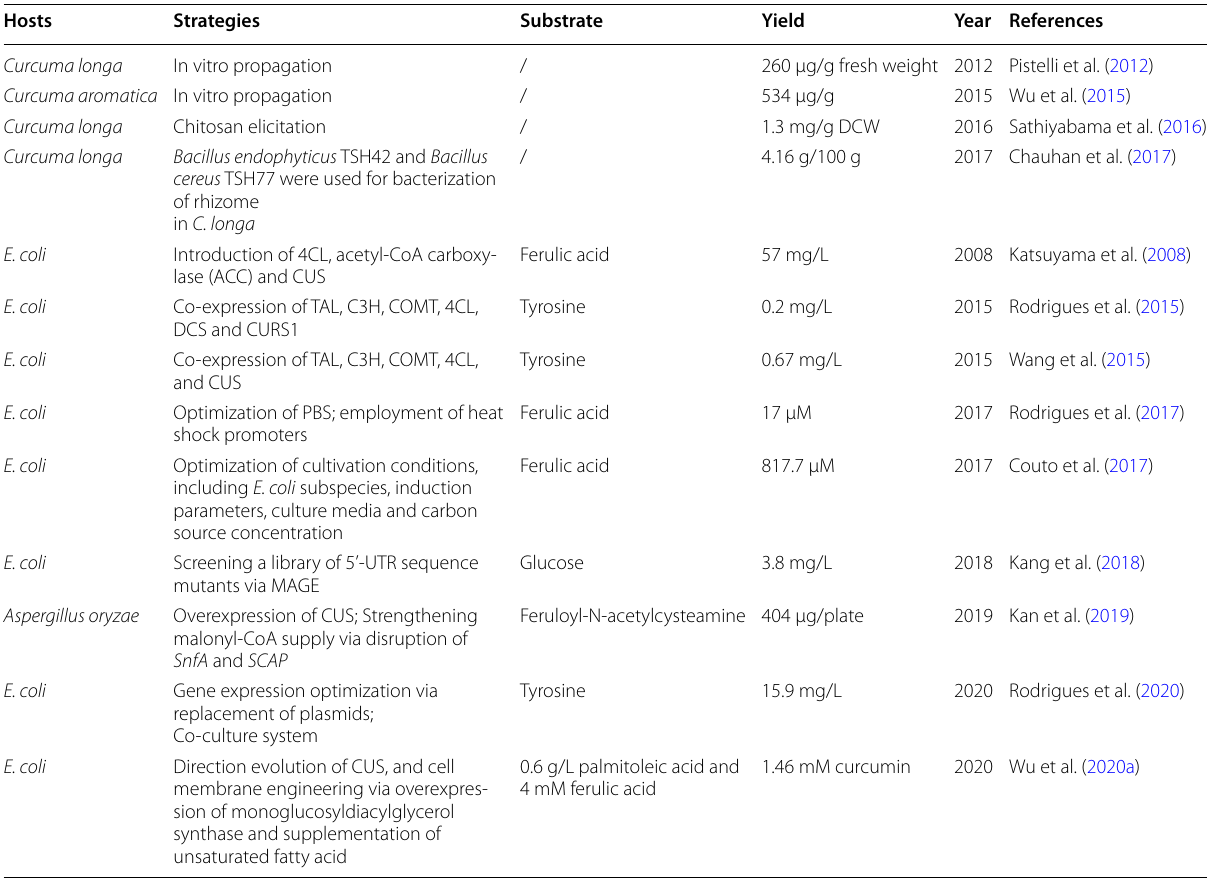
Table 4 Enhancement of curcumin production by metabolic